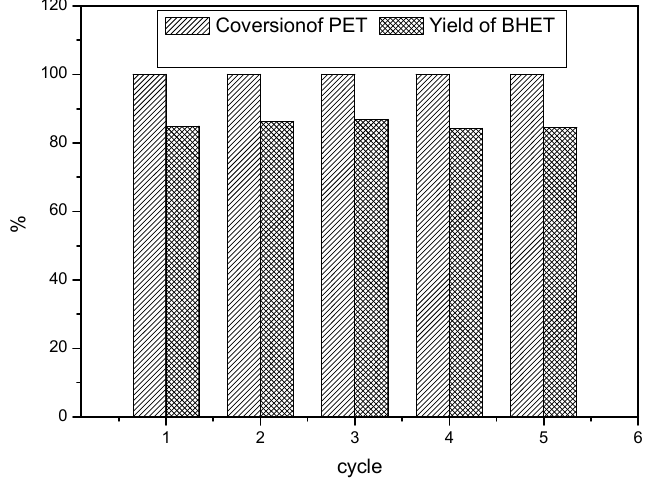
in the glycolysis of PET. 3